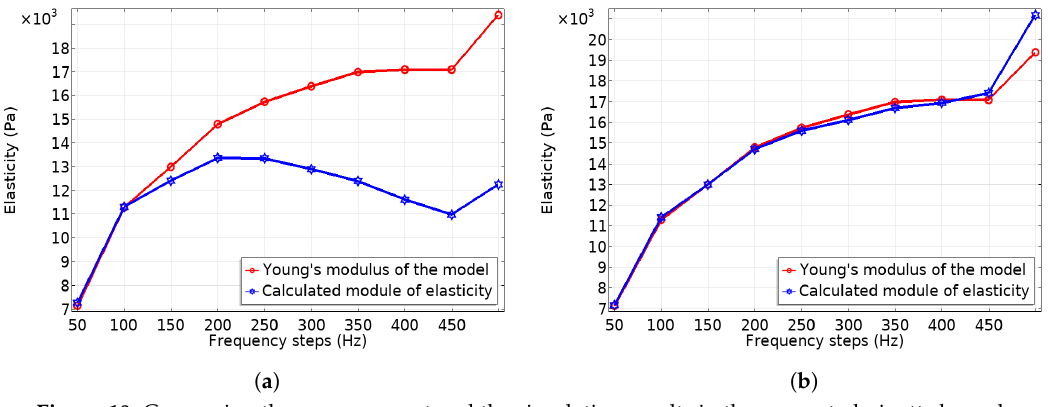
Figure 10. Comparing the measurement and the simulation results in the connected pipette boundary condition; the Young’s modulus and the calculated elastic modulus, ( a ) by Equation (1) and ( b ) by Equation